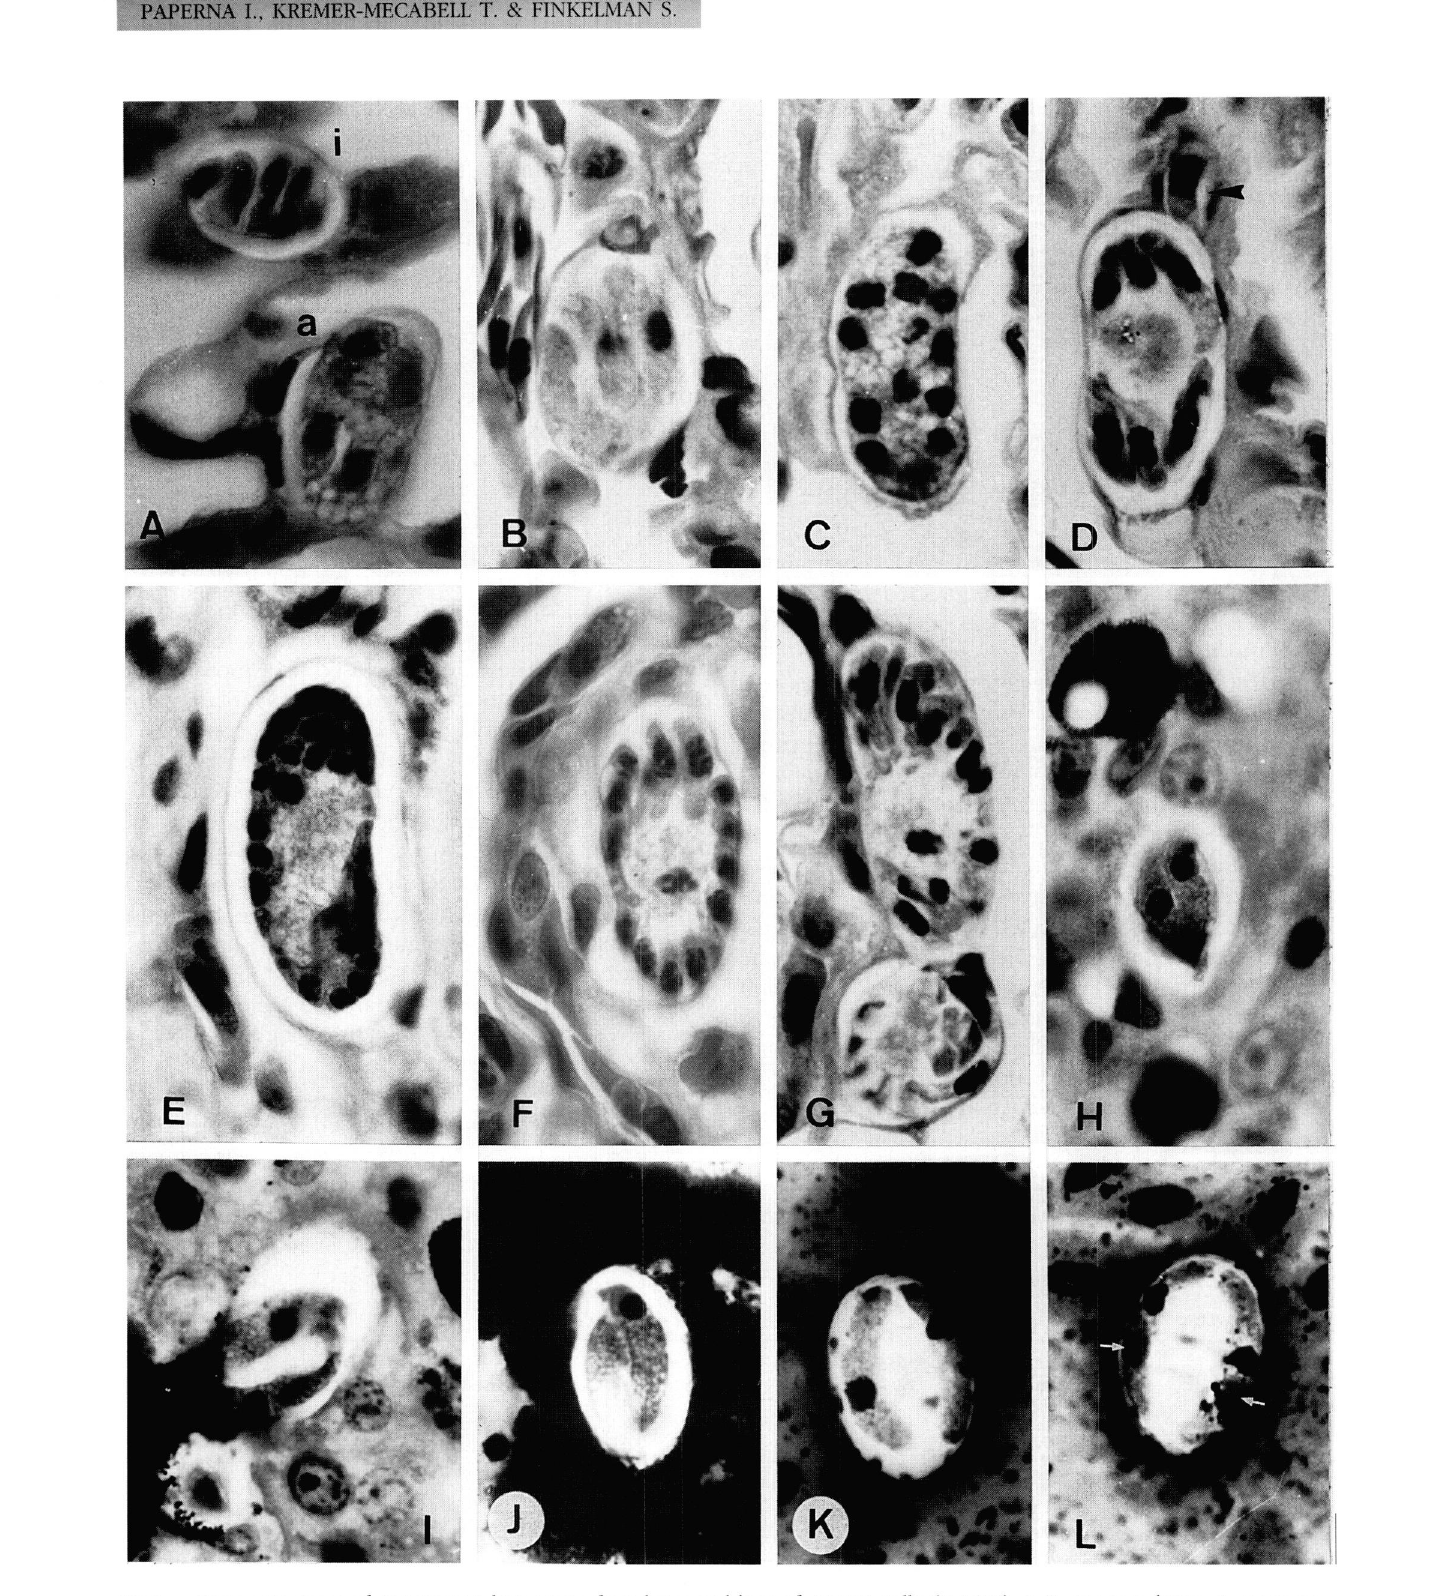
Parasite, 2002, 9,